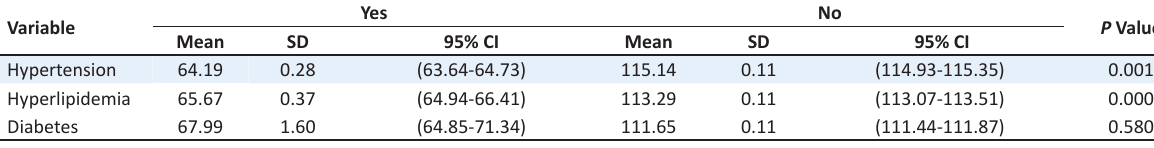
Table 2. Comparison of mean and standard deviation of GFR in relation to non-communicable diseases Variable